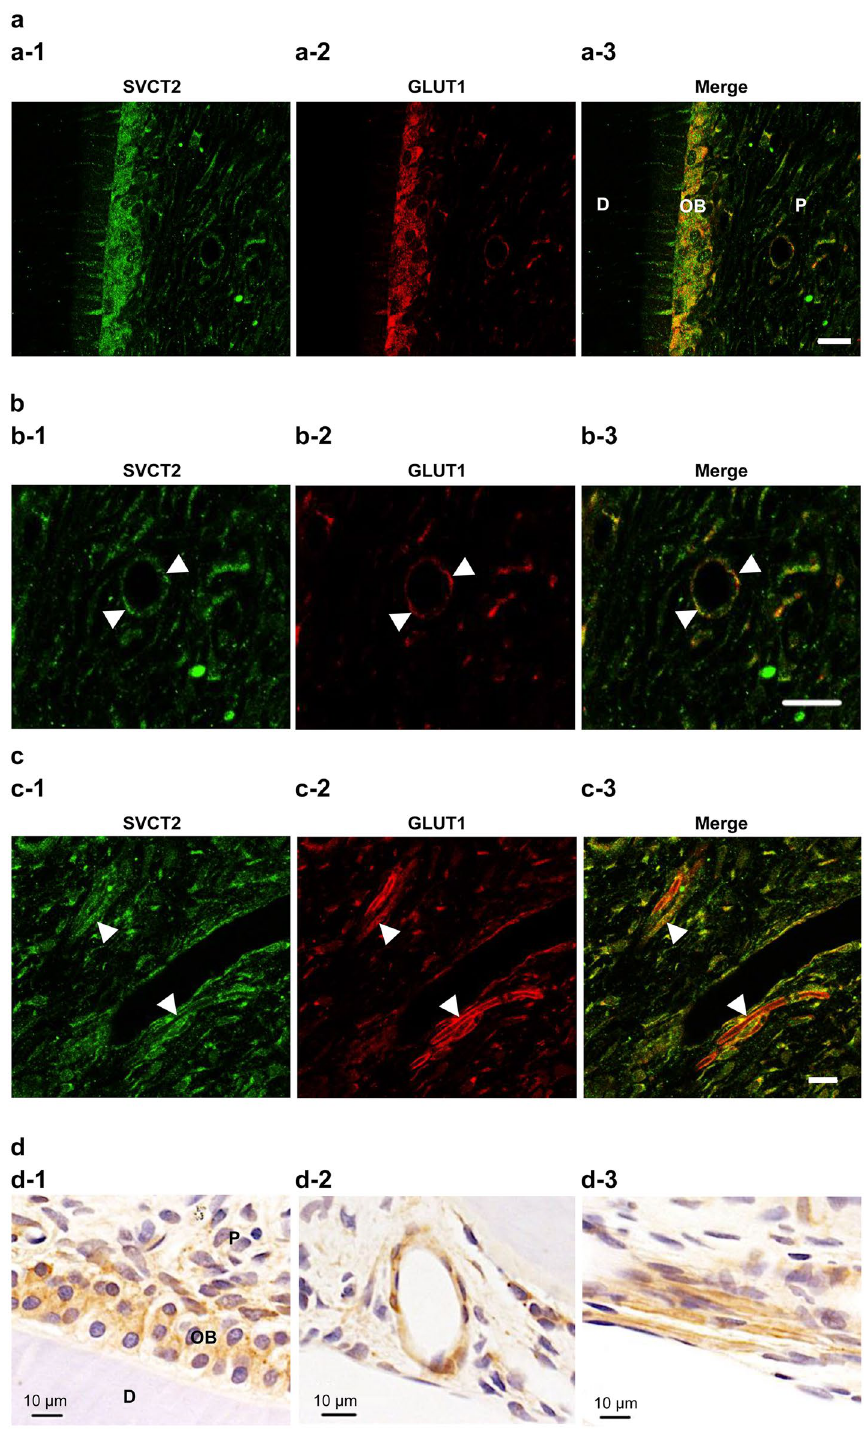
Figure 2. SVCT2 was colocalized in glucose transporter 1 (GLUT1) in odontoblasts, blood vessels, and nerve fibers in normal pulp tissue. Double immunofluorescence staining of (a-1, b-1, and c-1) SVCT2 (green) and (a-2, b-2, and c-2) GLUT1 (ted). (a-3, b-3, and c-3) Merged images. (b-1–b-3) The arrowheads indicate the blood vessel. (c-1–c-3) The arrowheads indicate the nerve fibers. ( d ) Immunochemical stating of GLUT1. D, dentin, OB, odontoblast, P, dental pulp. Scale = 20